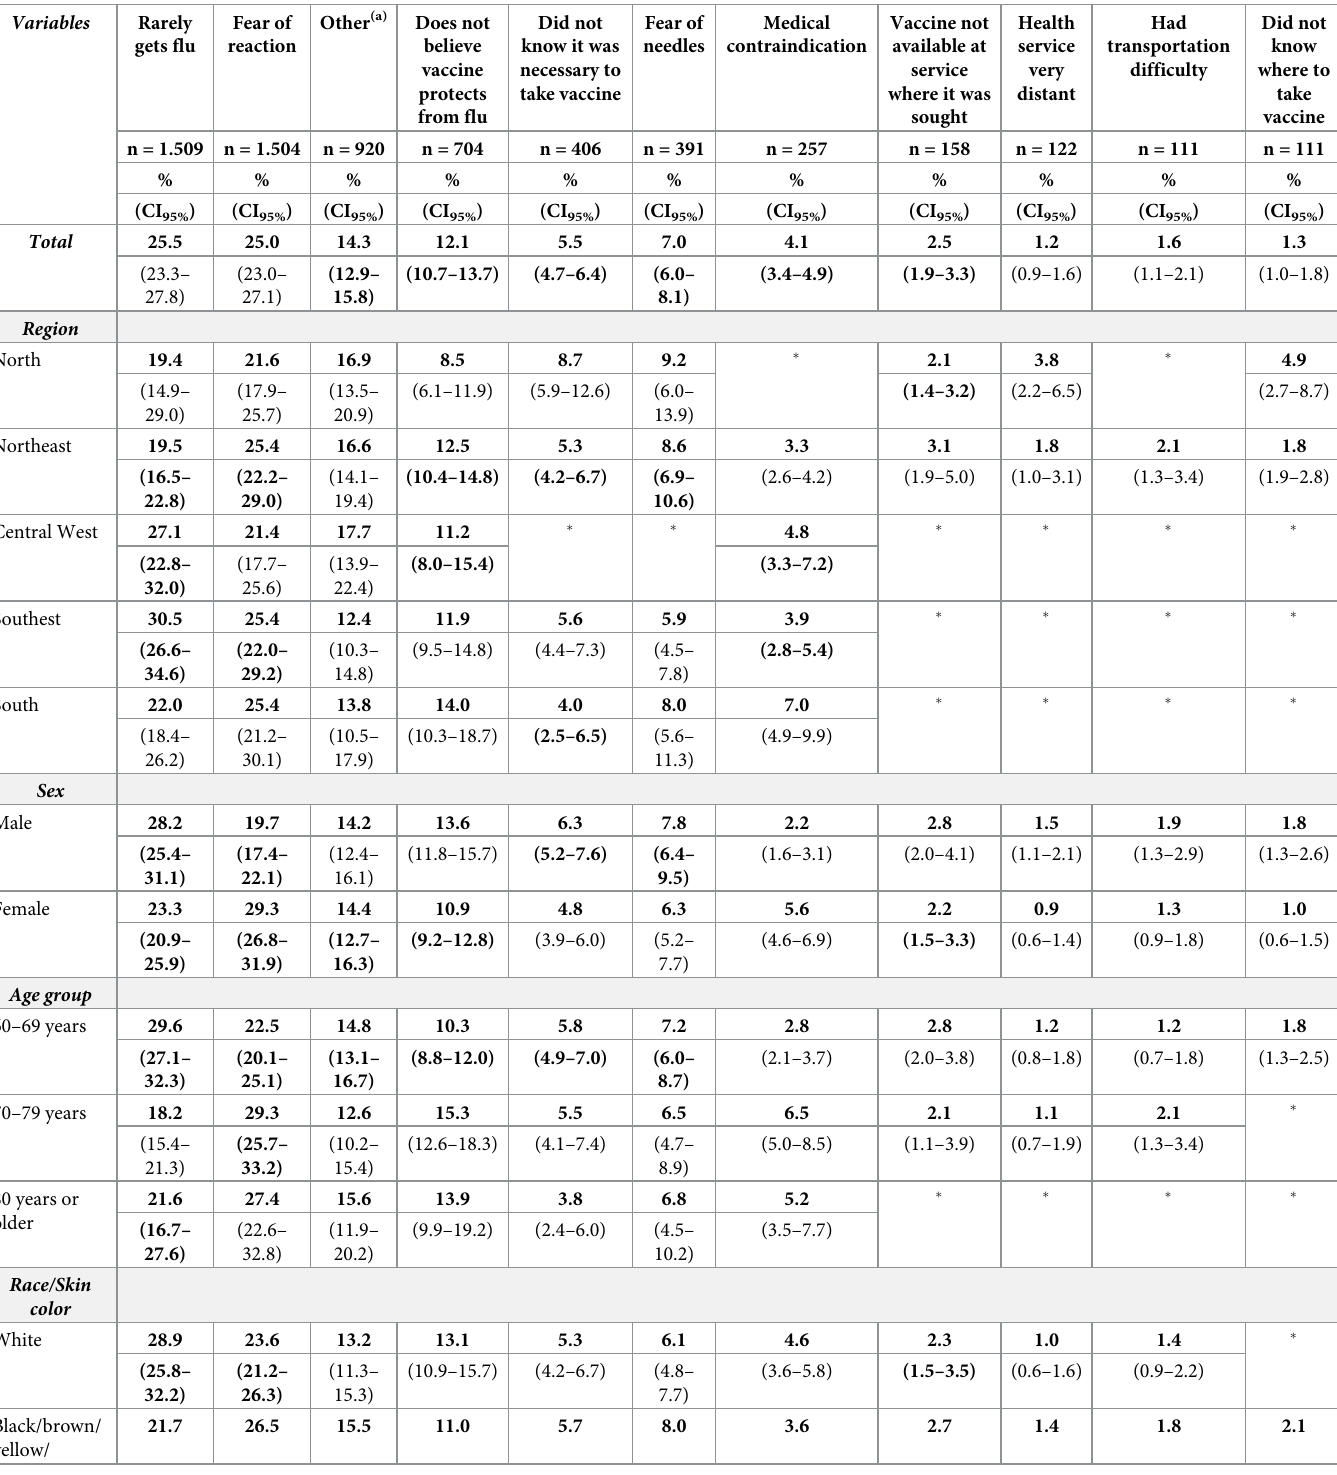
Table 2. Distribution of reasons for nonadherence of older people to vaccination for influenza according to sociodemographic characteristics. National Health Sur- vey, Brazil, 2013.